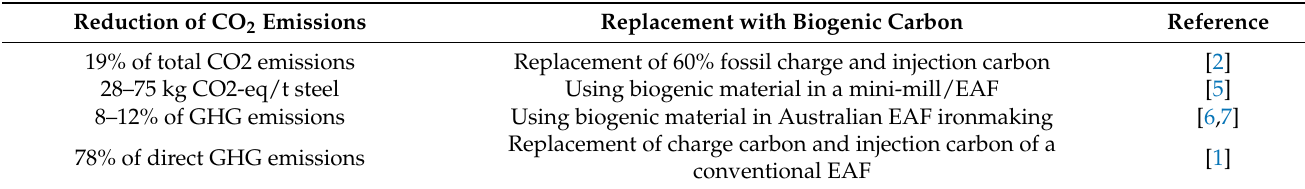
Table 2. Estimated reduction of GHG emissions in EAF steelmaking via utilization of biogenic carbon. Reduction of CO 2 Emissions Replacement with Biogenic Carbon